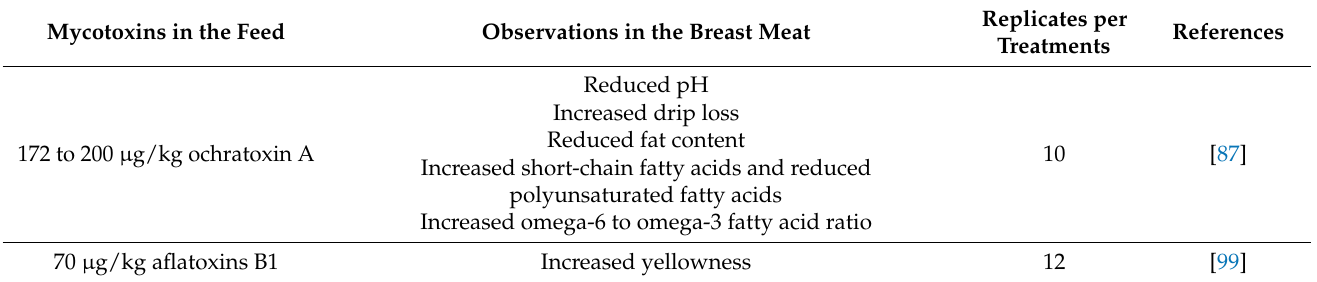
Table 5. Effects of mycotoxins on the meat quality of broiler